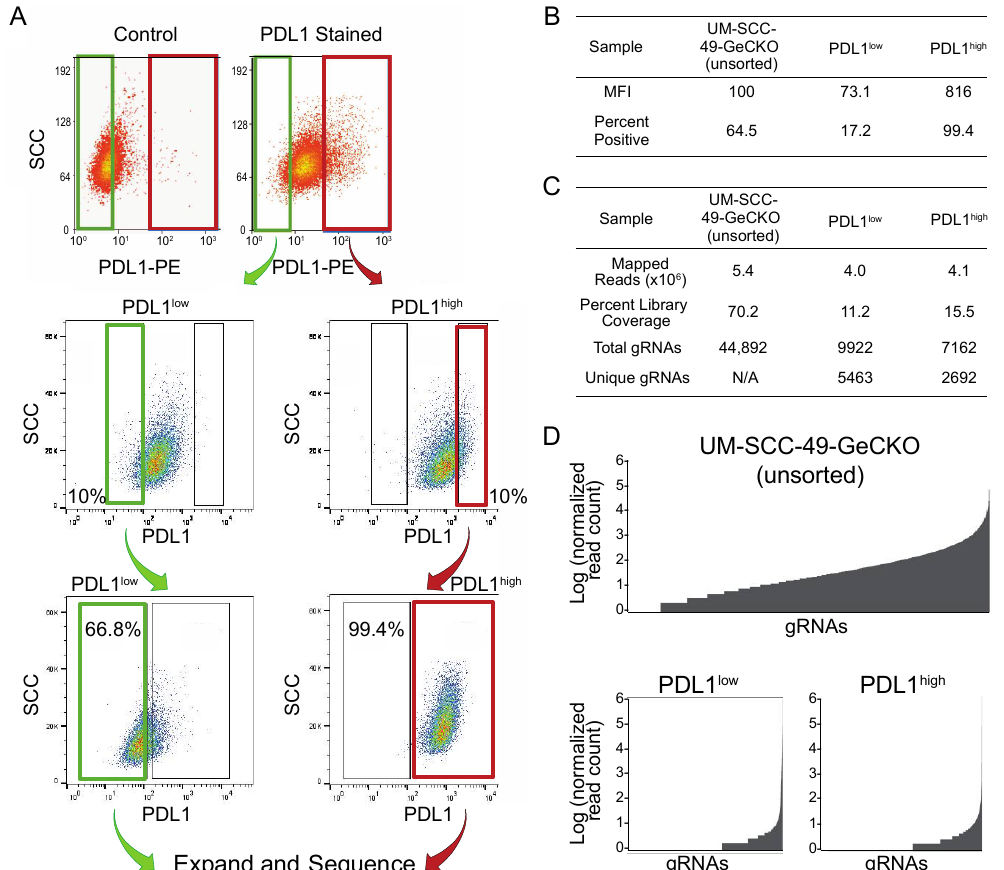
Figure 2. Sorting of UM-SCC-49-GeCKO pool for PDL1 enhanced or deficient cells. ( A ) UM-SCC-49 cells infected with the GeCKO library were treated with 10 ng/mL IFN γ for 72 h and stained using a PE-conjugated antibody directed against PDL1. Cells were then subjected to fluorescence-activated cell sorting. Gates were drawn to select the 10% of cells with lowest fluorescence (PDL1 low ; upper plots) and 10% with the highest (PDL1 high ; upper plots). Green and red gates indicate populations of cells collected for PDL1 low and PDL1 high , respectively. The selected populations were expanded separately in culture to 30 million cells each, then subjected to cell sorting again, selecting the lowest 10% of cells from PDL1 low and the highest 10% of cells from PDL1 high (middle plots). Again, these cells were expanded and analyzed by flow cytometry a third time to ensure divergent phenotypes. “positive” and “negative” gates were drawn based on 0.1% and 99% (respectively) of a control stained with secondary antibody only (lower plots). At this point, all PDL1-negative (PDL1 low ) and all PDL1-positive (PDL1 high ) cells were selected, and genomic DNA was harvested. ( B ) Median fluorescence intensities (MFIs) and percent of cells positive for PDL1 are reported for the final sort for each population. ( C ) Mapping statistics from UM-SCC-49-GeCKO sequencing results. ( D ) Distribution of read counts across gRNAs (normalized to total reads for each sample and log transformed).